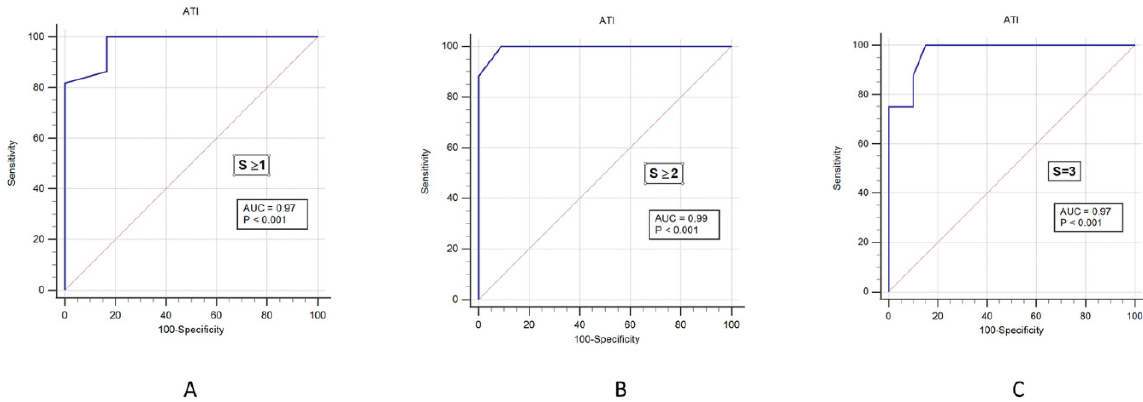
Figure 5. The AUROC of ATI for detecting different grades of liver steatosis. A: Liver steatosis grade S1 or higher with AUROC values of 0.97 (95% confidence interval (CI): 0.83–1.00) for ATI. B: Liver steatosis grade S2 or higher with AUROC values of 0.99 (95% CI: 0.86–1.00) for ATI. C: Liver steatosis grade S3 with AUROC values of 0.97 (95% CI: 0.82–1.00) for ATI. AUROC: area under the receiver-operating characteristic curve; ATI: attenuation imaging.